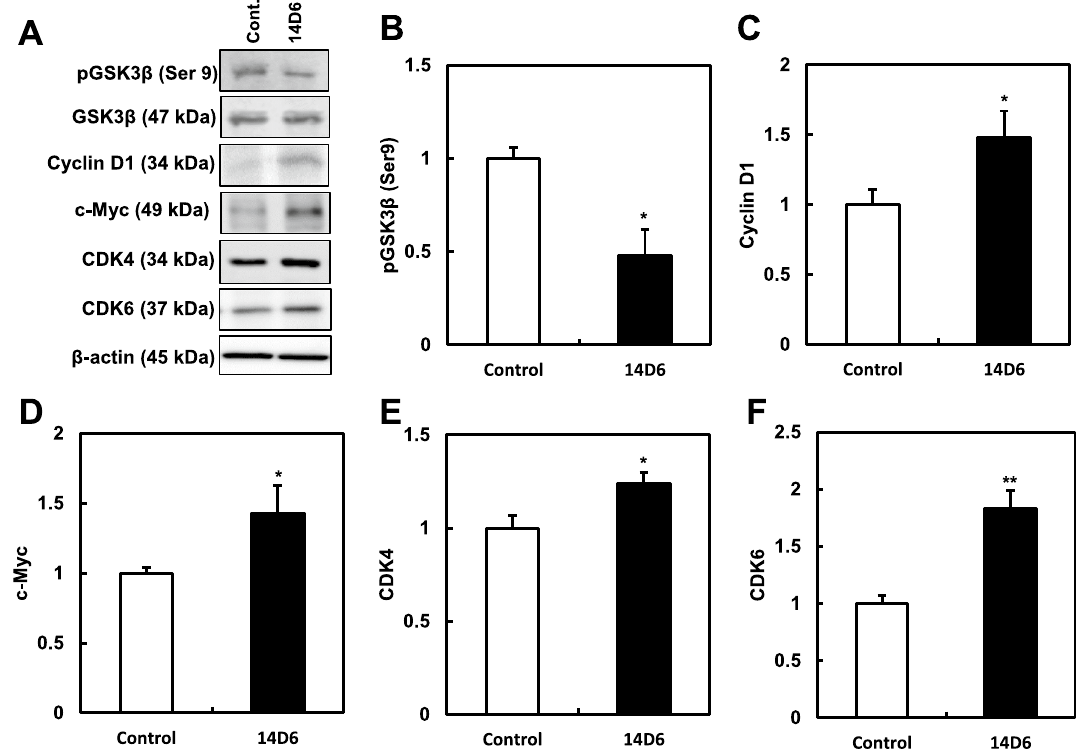
Figure 5. Activation of PDGFR signal transduction pathway-related kinases and targets in PDGFRA -mutated HEK293T cells. (A–F) The levels of pGSK3β Ser9 were decreased in 14D6 cells (A,B) . The expression of the PDGFR signal transduction pathway targets, cyclinD1 (A,C) , c-Myc (A,D) , CDK4 (A,E) , and CDK6 (A,F) , was increased in 14D6 compared to isogenic control cells. The amounts of phosphorylated proteins were normalized to those of total proteins. *, p < 0.05; **, p < 0.01. For uncropped blot source of (A) , see Supplemental Fig. S13.